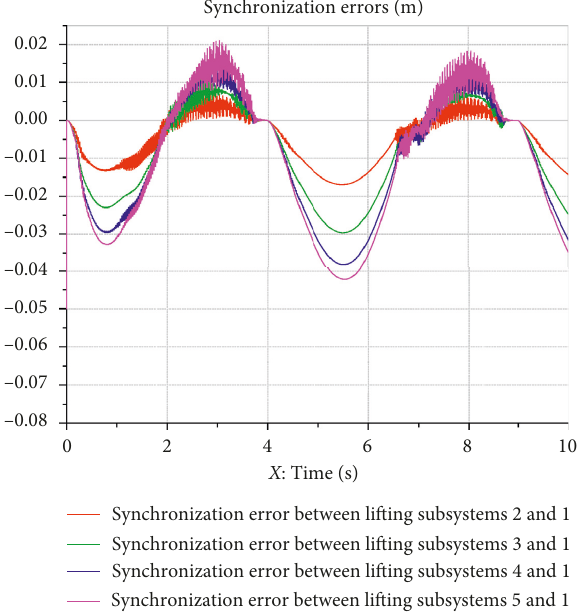
Figure 6: Lifting heights of the system with proposed controller.